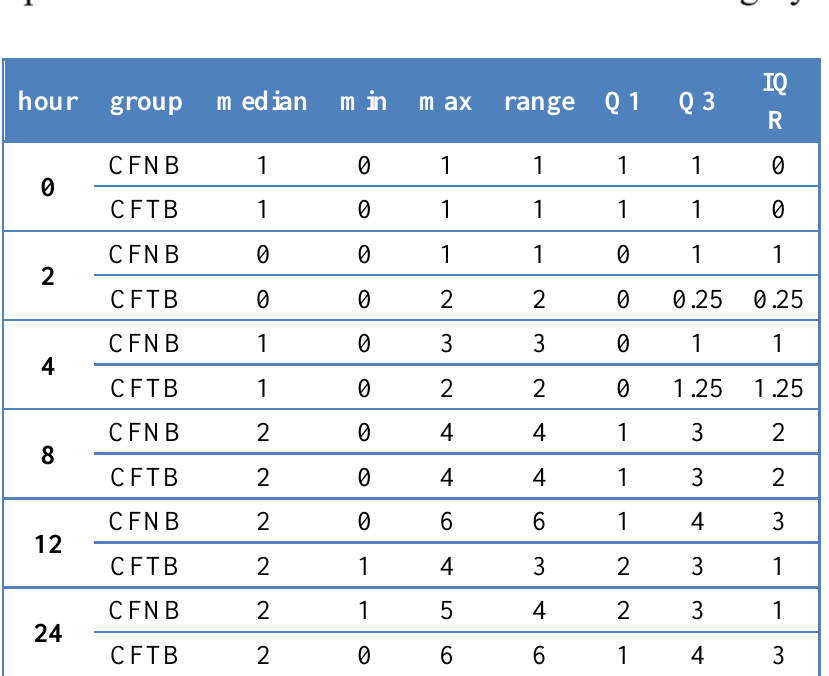
Figure 4. Characteristics of pain after surgery on the NRS scale. p = 0.08.